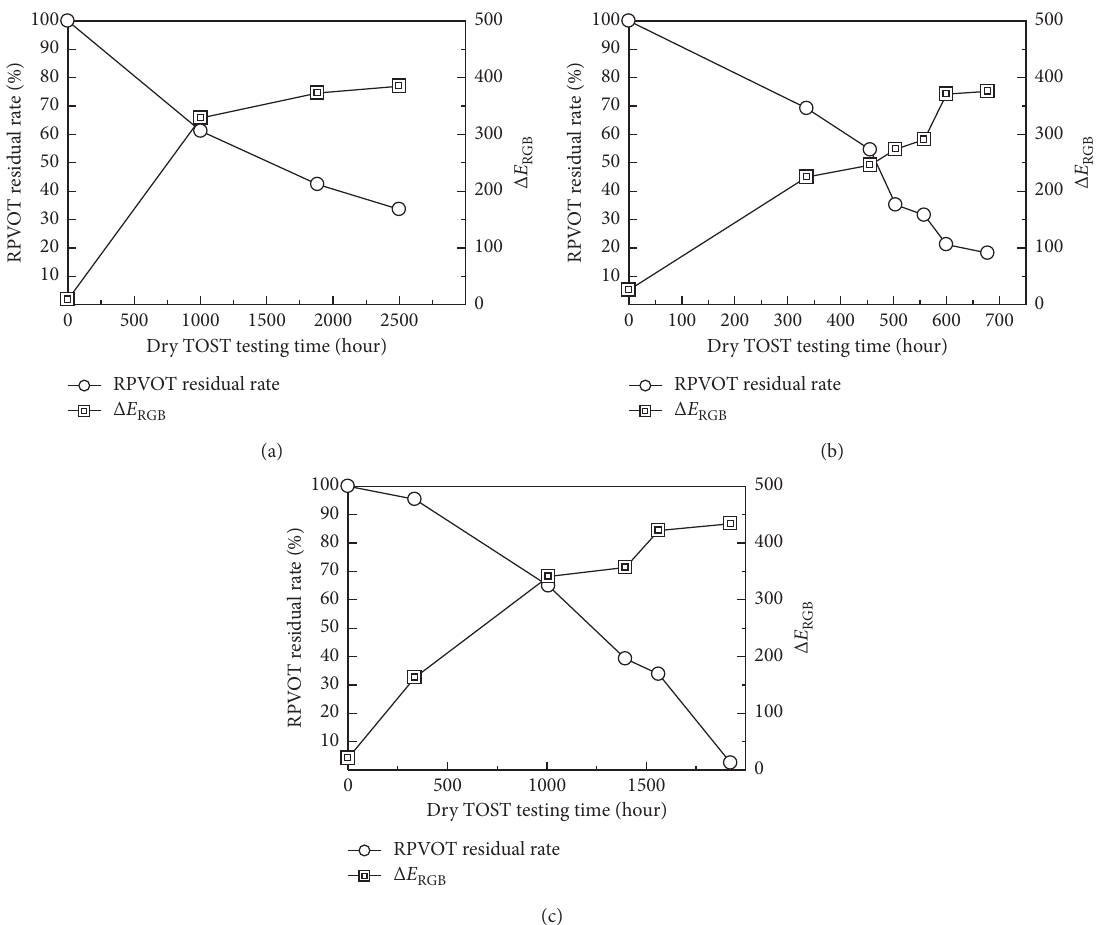
Figure 6: Relationship between Dry TOSTtesting time, PVOTresidual rate and Δ E